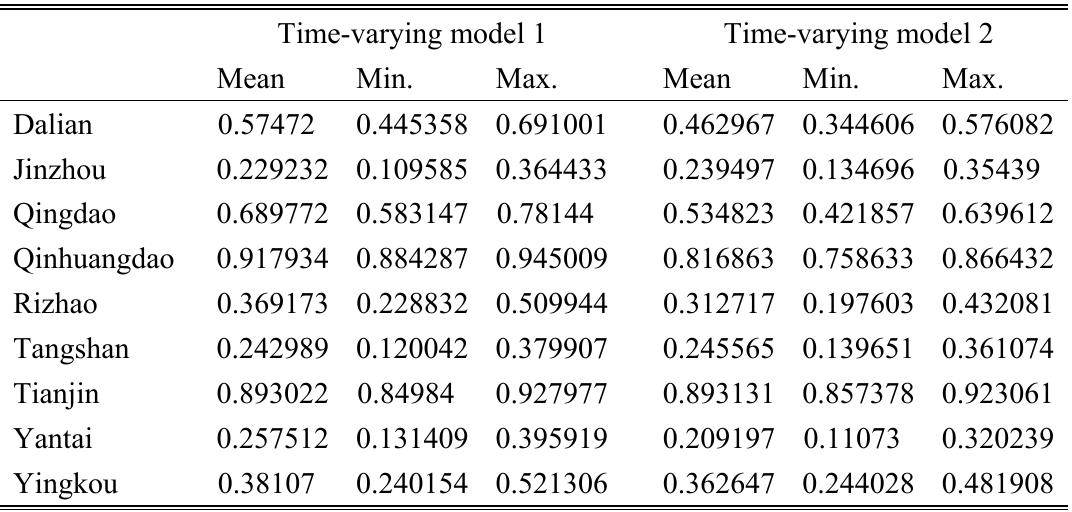
Table 6. Report of the Efficiency Scores Time-varying model